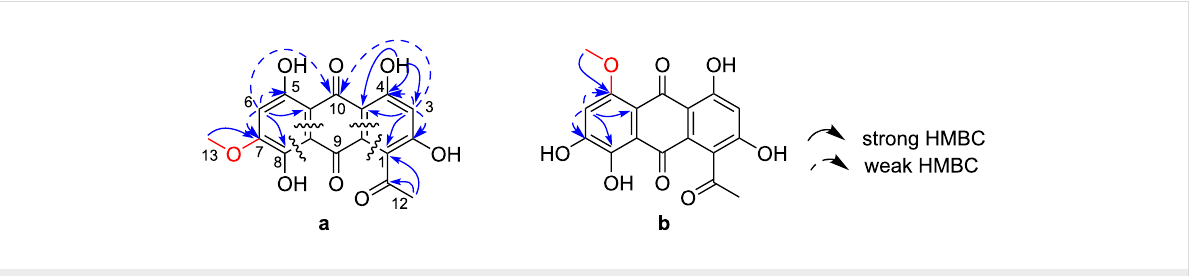
Figure 2: Key HMBC correlations and two possible structures ( a and b ) for karimunone A ( 1 ).